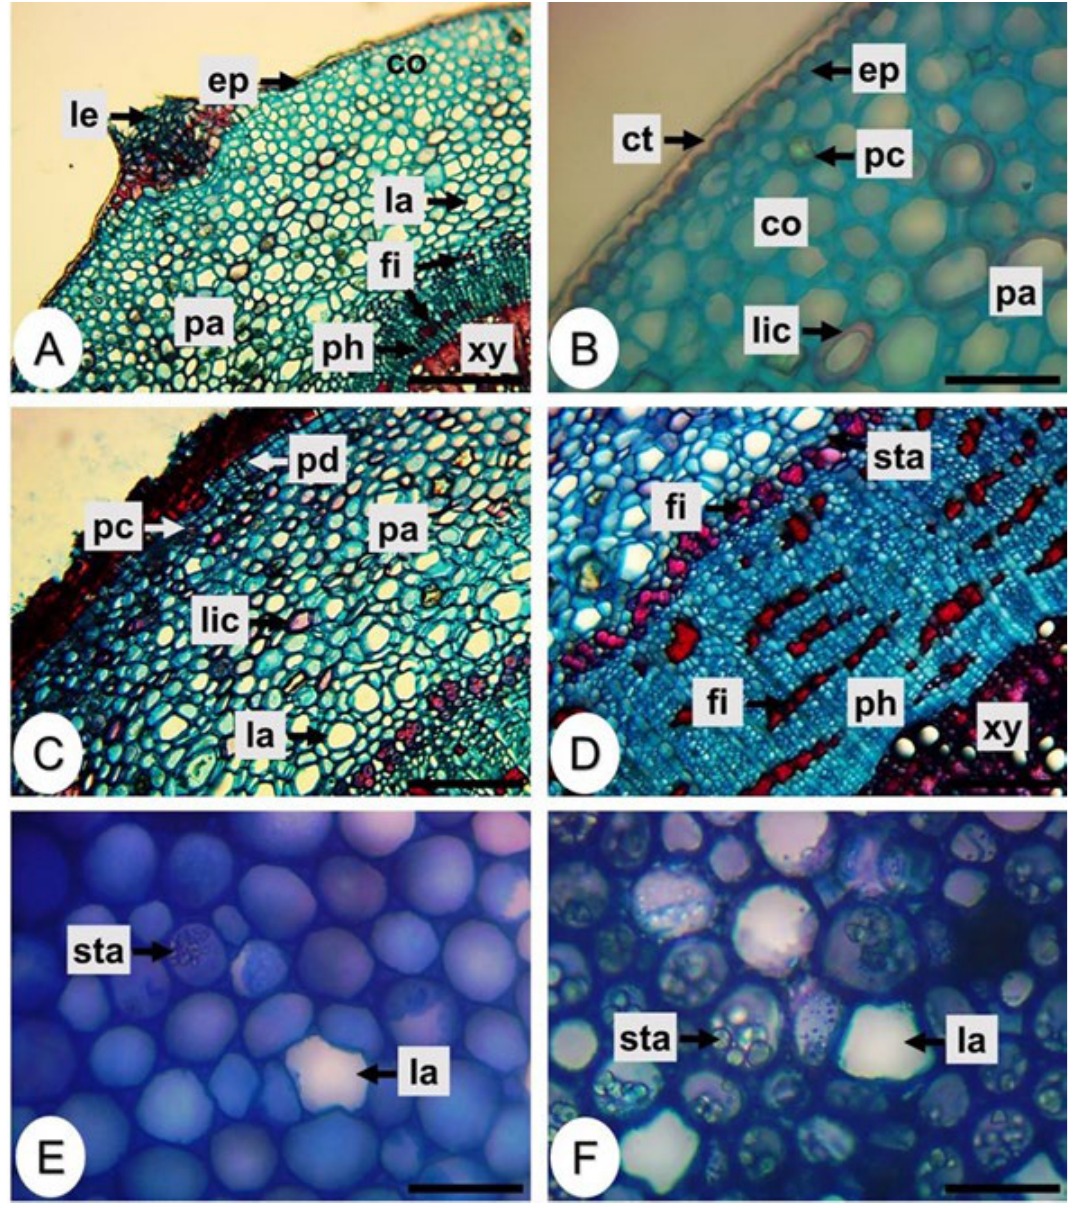
FIGURE 1 - Cross-sections of the stem of Manilkara zapota (L.) P.Royen (Sapotaceae). A, B, E: primary growth. C, D, F: secondary growth. Abbreviations: co = collenchyma; ct = cuticle; ep = epidermis; fi = fiber; la = laticifer; le = lenticel; lic = lignified cell; pa = parenchyma; pc = prismatic crystal; pd = periderm; ph = phloem; sta = starch; xy = xylem. Bars: A, D, E = 200 µm; B, C, F = 50